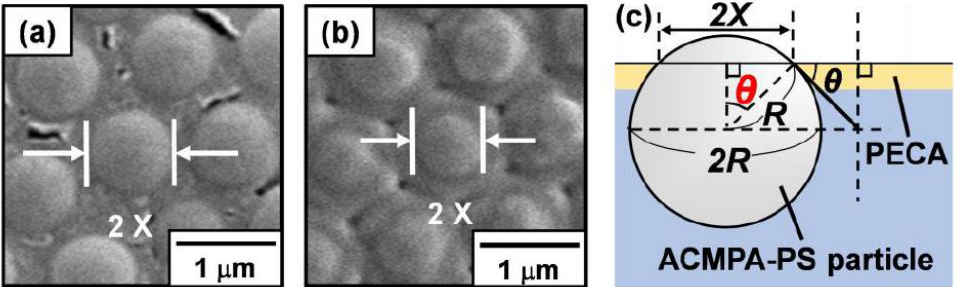
Figure 5. SEM images of ACMPA-PS particles prepared at ( a ) pH 2.0 and ( b ) 4.8 trapped with poly(ethyl 2-cyanoacrylate) (PECA) films recorded from the air-exposed side of the films. ( c ) Determination of the contact angle (through water) of the ACMPA-PS particle at the air–water interface using SEM images.